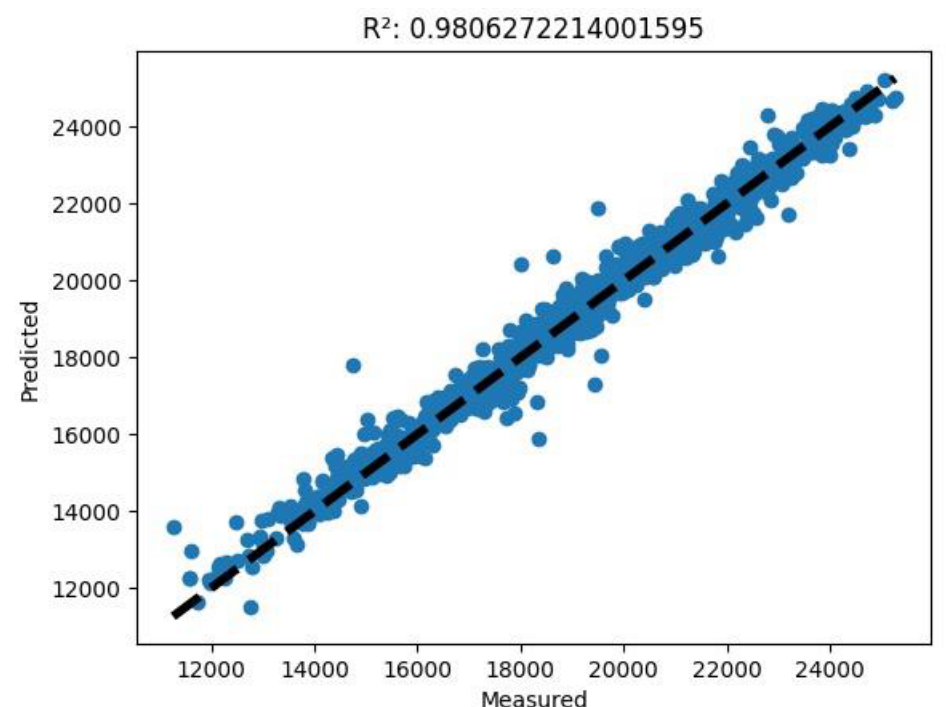
Figure 14. A predicted versus measured graph resulting from the validation process of V-MLP-12.